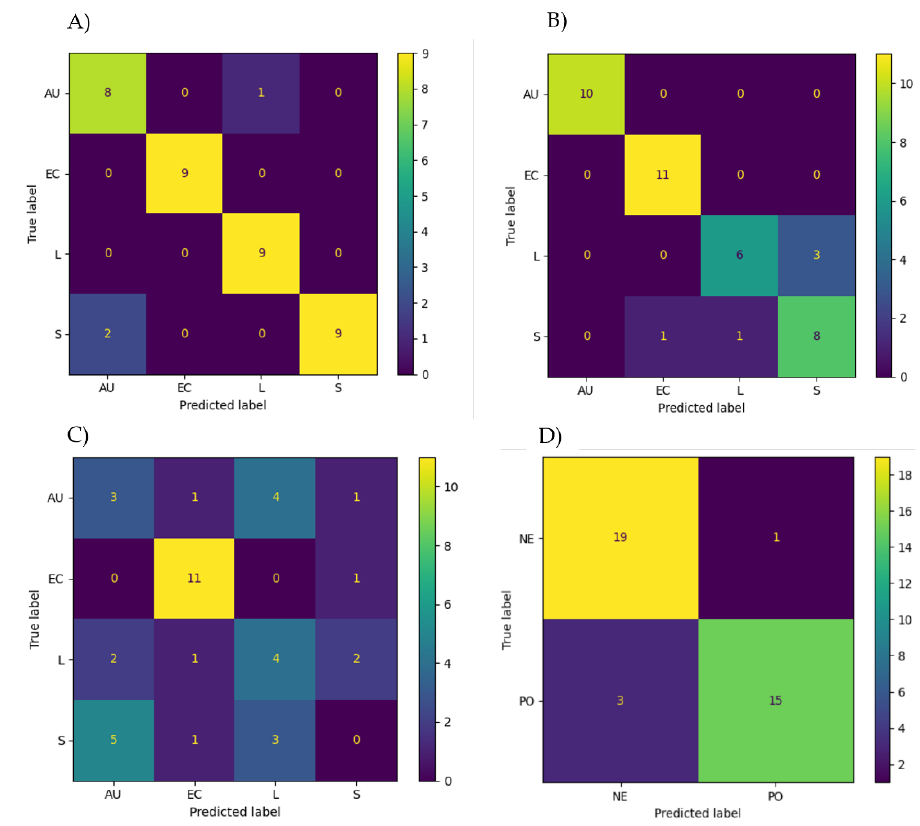
Figure 3. Confusion matrices of SVM 5-fold cross-validation for monocultures: S. aureus (AU), E. coli (EC), L. monocytogenes (L), and S. enterica (S); at three different times: ( A ) 24, ( B ) 18, and ( C ) 8 h; ( D ) confusion matrix of SVM 5-fold cross-validation for Gram-positive (PO)/Gram-negative (NE) at 24 h. Higher numbers show a stronger correlation between the predicted and the actual label.